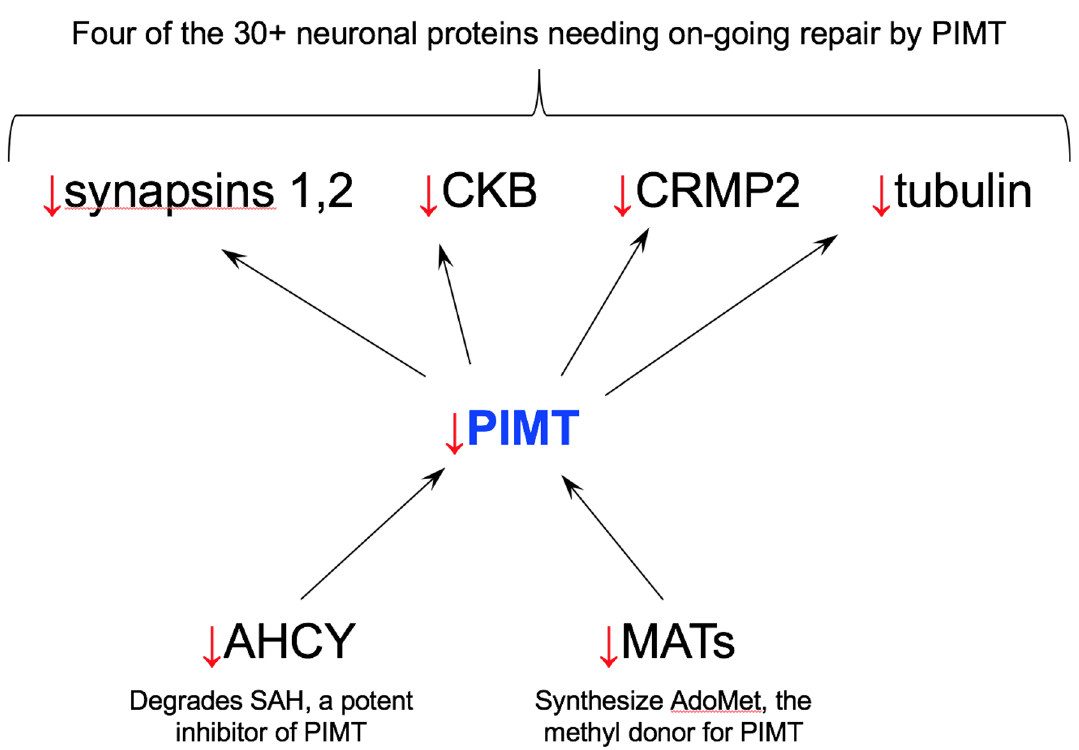
Fig 6. Illustration of interactions by which PIMT deficits could amplify the effects of deficits in other proteins. Abbreviations: CKB (creatine kinase B), CRMP2 (collapsin response mediator protein 2), AHCY (S-adenosyl-L-homocysteine hydrolase), MATs (methionine adenosyl transferases). The PIMT repair targets shown in this diagram are among those identified by Zhu et al. [23] via proteomic analysis of brain extracts from PIMT KO